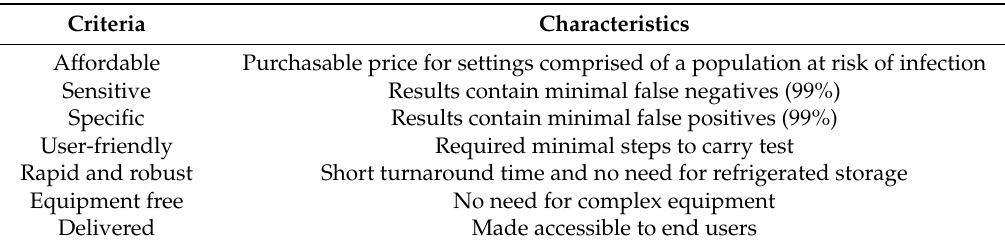
Table 1. The ASSURED (Affordable, Sensitive, Specific, User friendly, Rapid and to enable treatment at first visit and Robust, Equipment free and Delivered to those who need it) criteria for ideal point-of-care (POC) diagnostics for use in resource-limited settings